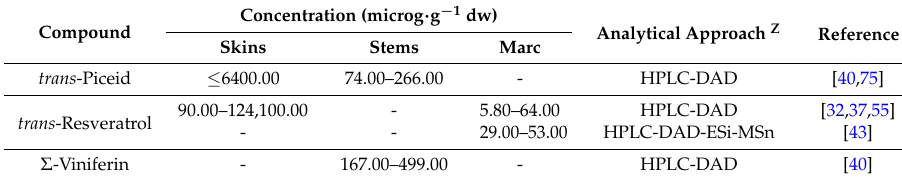
Table 5. Stilbenes present in winery